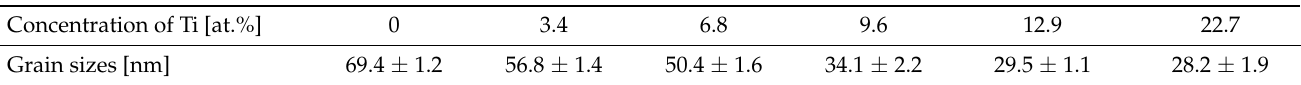
Figure 2. XRD patterns of WTi alloy films as a function of Ti concentrations. Table 3. Grain sizes of the WTi films with respect to the Ti content. Concentration of Ti